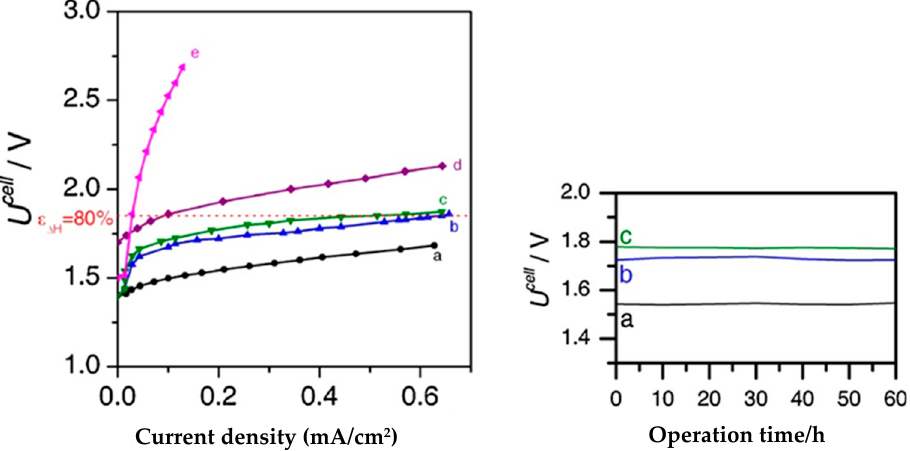
Operation time/h Figure 12. ( left ) Current-voltage performances for a 7 cm 2 single cell with different MEAs: Figure 12. ( left ) Current ‐ voltage performances for a 7 cm 2 single cell with different MEAs: (a) (a) Ir(O 2 )/Nafion 117/Pt(H 2 ), (b) Ir/Nafion 117/[Co(dmg) 3 (BF) 2 ]BF 4 -Vulcan XC72, (c) Ir/Nafion Ir(O 2 )/Nafion 117/Pt(H 2 ), (b) Ir/Nafion 117/[Co(dmg) 3 (BF) 2 ]BF 4 ‐ Vulcan XC72, (c) Ir/Nafion 117/[Co(dmgBF 2 ) 2 ]-Vulcan XC72, (d) Pt/Nafion 117/Pt, (e) Ir/Nafion 117/[Co(acac) 3 ]-Vulcan XC72. 117/[Co(dmgBF 2 ) 2 ] ‐ Vulcan XC72, (d) Pt/Nafion 117/Pt, (e) Ir/Nafion 117/[Co(acac) 3 ] ‐ Vulcan XC72. Experiments were carried at 60 ◦ and P = 1 atm. ( right ) Stability of the cells at 0.2 A/cm 2 . Reprinted Experiments were carried at 60° and P = 1 atm; ( right ) Stability of the cells at 0.2 A/cm 2 . Reprinted with permission from [165]. Copyright 2012 with permission from [165]. Copyright 2012 Elsevier.